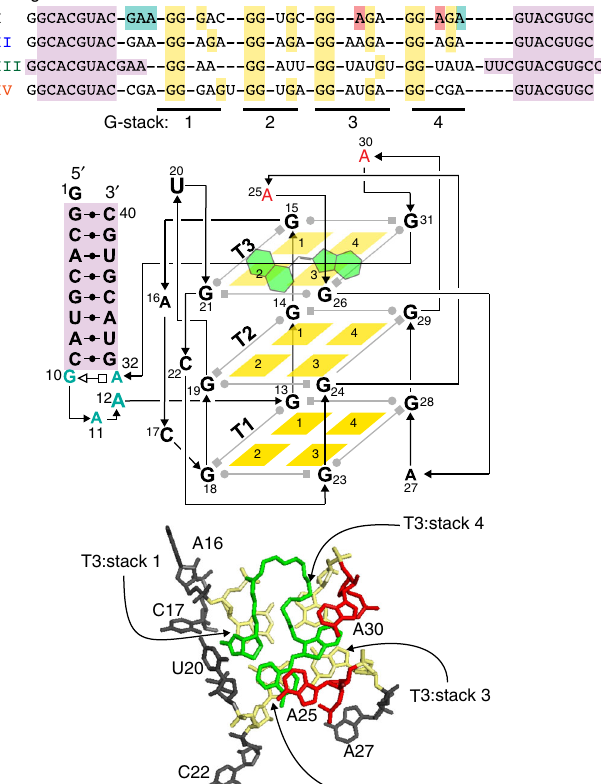
Fig. 1 RNA Mango aptamers core sequences. Colour-coded alignment of RNA Mango I, II, III and IV. G residues in yellow are protected from dimethyl sulfate (DMS) cleavage when folded in the presence of fl uorophore. Quadruplex stacks and their associated propeller sequences are numbered 1 through 4. The GAAA isolation motif of Mango I, together with two adenines essential for binding, are shown in green and red respectively. Purple shading represents a fl anking stem region for all four Mango aptamers. Schematic: a tertiary structure of Mango I, showing tier 1, 2 and 3 of its quadruplex structure (T1, T2 and T3) and colour-coded as in top panel. TO1-B is shown in green. Bottom: top view of the Mango I core (PDB ID: 5V3F 16 ), showing the T3 tier of the quadruplex and relevant propeller residues, colour coding matches the schematic and top